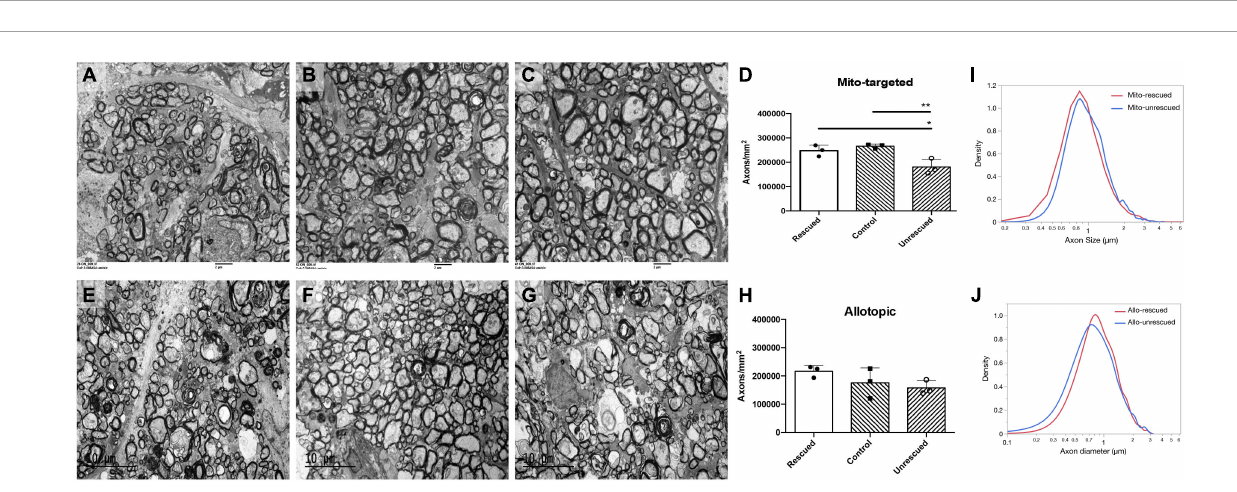
FIGURE5 Wild type ND4 protect optic nerve degeneration. Transmission electron micrographs of the retrobulbar optic nerve were performed 15 months post-injection. More cystic spaces are observed in un-rescued mice (A,E) when compared to mcherry double-injected control (B) , mito-targeted ND4 rescued (C) , naïve (F) , and allotopic expressed ND4 rescued (G) mice. Quantification of axons in the mice of mito-targeted (D) and allotopic (H) rescue experiments. Only mito-targeted ND4 significantly preserved axons compared to its corresponding non-rescued controls. In contrast, allotopic expressed ND4 did not. Analysis of the distribution of axonal diameters showed that mito-targeted ND4 (I) preserved small axons with a shift to larger diameter axons in the corresponding non-rescued compared to the allotopic group (J)